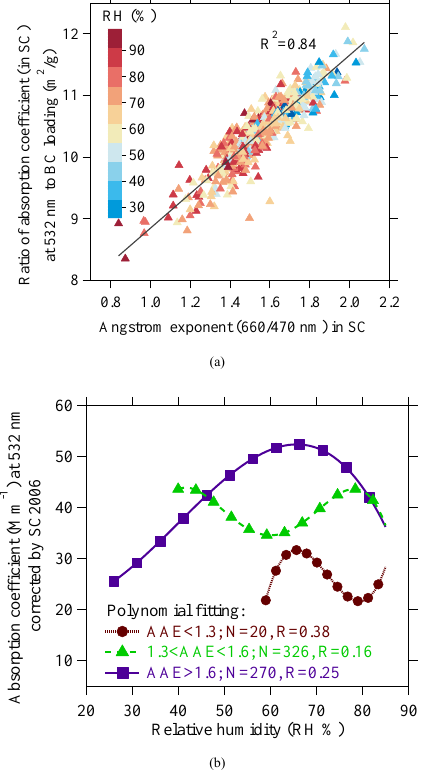
Figure 10. Relationships between the aerosol mass (or specific) ab- sorption coefficient (m 2 g − 1 ) and its Ångström exponent ( a , scatter plots) and the effects of relative humidity on the aerosol absorption coefficient ( a , in color) and (b) in different absorption Ångström exponent